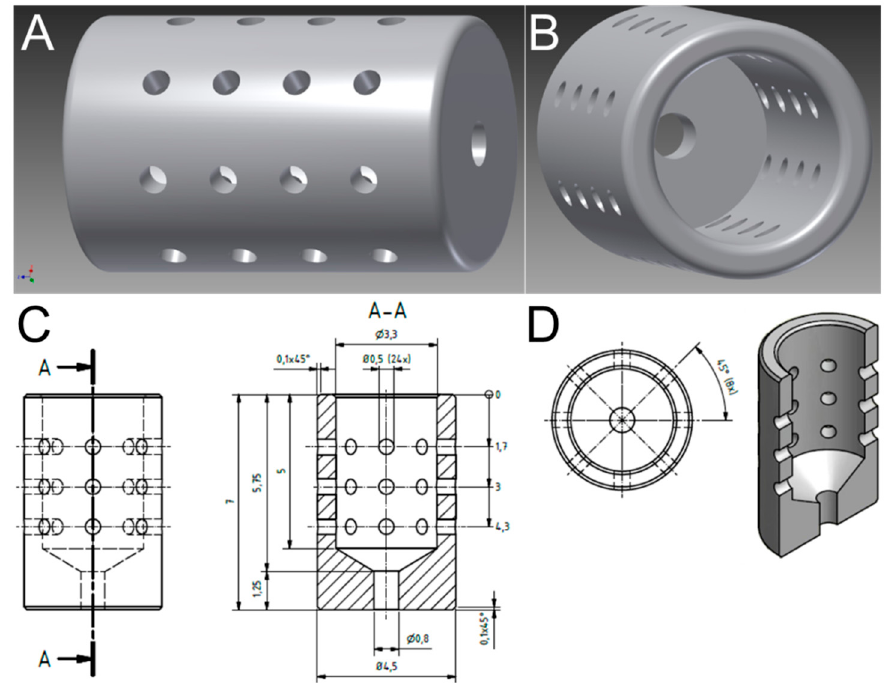
Figure 1. Details of cylindrical titanium implants. Holes were drilled in titanium cylinders ( A , B ). Cylindrical implant contains 24 holes, in the periphery each 0.5 mm in diameter, 1 hole at the bottom 0.8 mm and an opening at the top 3.3 mm ( C , D ).